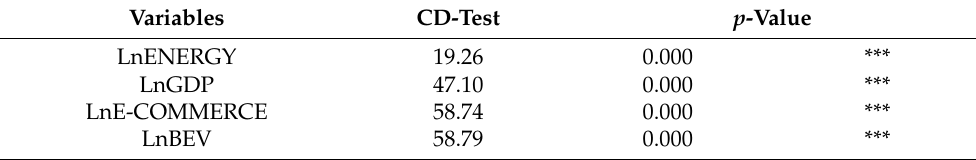
Table 6. Pesaran CD-test.